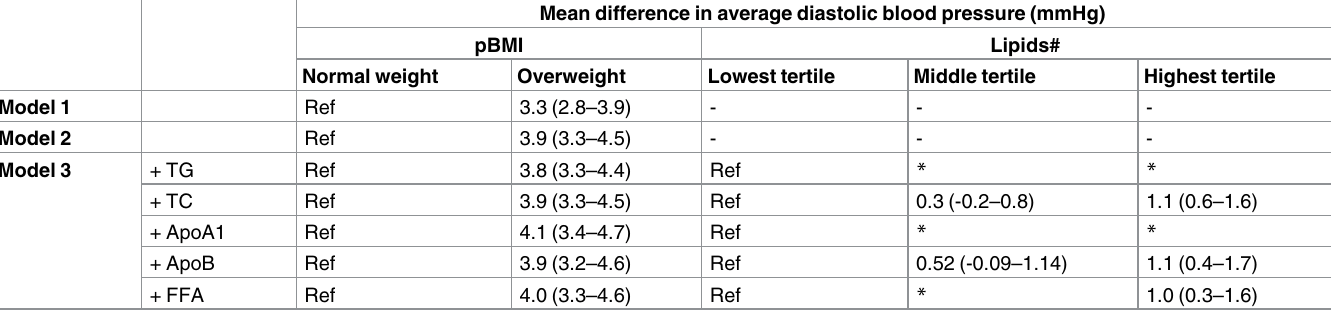
Table 4. Association between pre-pregnancy body mass index (pBMI) and diastolic blood pressurecourse during pregnancy, with maternal